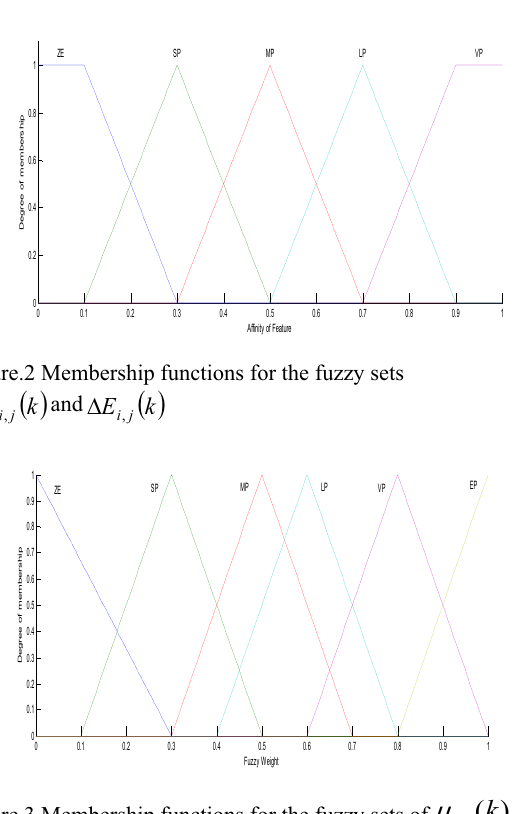
Figure.3 Membership functions for the fuzzy sets of )( , Unlike that of the input data, the output data have six fuzzy sets labeled in the linguistic terms of ZE, SP, MP, LP, VP and extremely large positive (EP). The membership functions of the fuzzy sets are defined by the triangular functions and the core of these fuzzy sets are not equally spaced. The membership functions of output are shown in Fig. 4. According to the input and output defined above, the fuzzy rules can be expressed by employing fuzzy IF-THEN rules as follows: